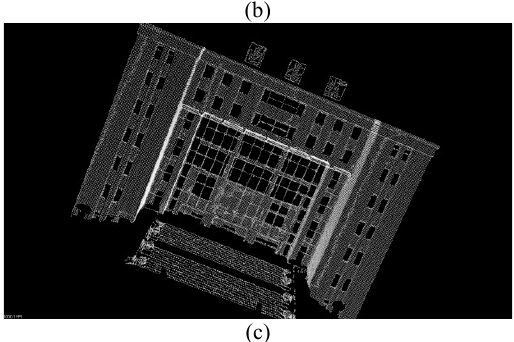
Figure 1. Point cloud effect diagram before and after preprocessing Table 1. Point cloud data segmentation performance